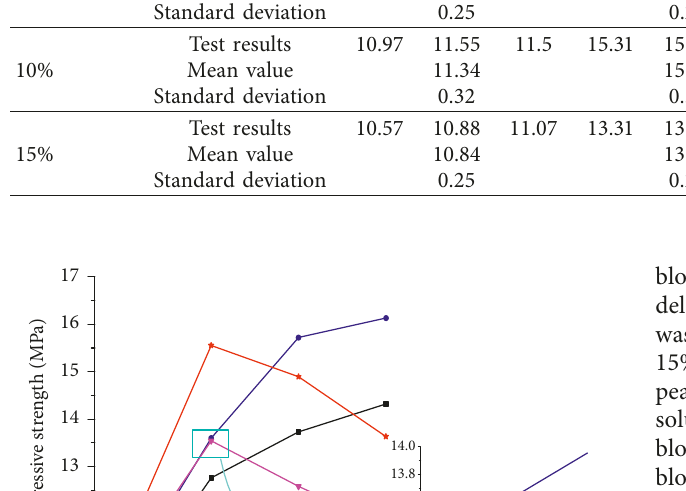
Table 5: Uniaxial compressive strength of filling paste after immersion in different concentrations of sulfate solution. Sulfate concentration Clean water